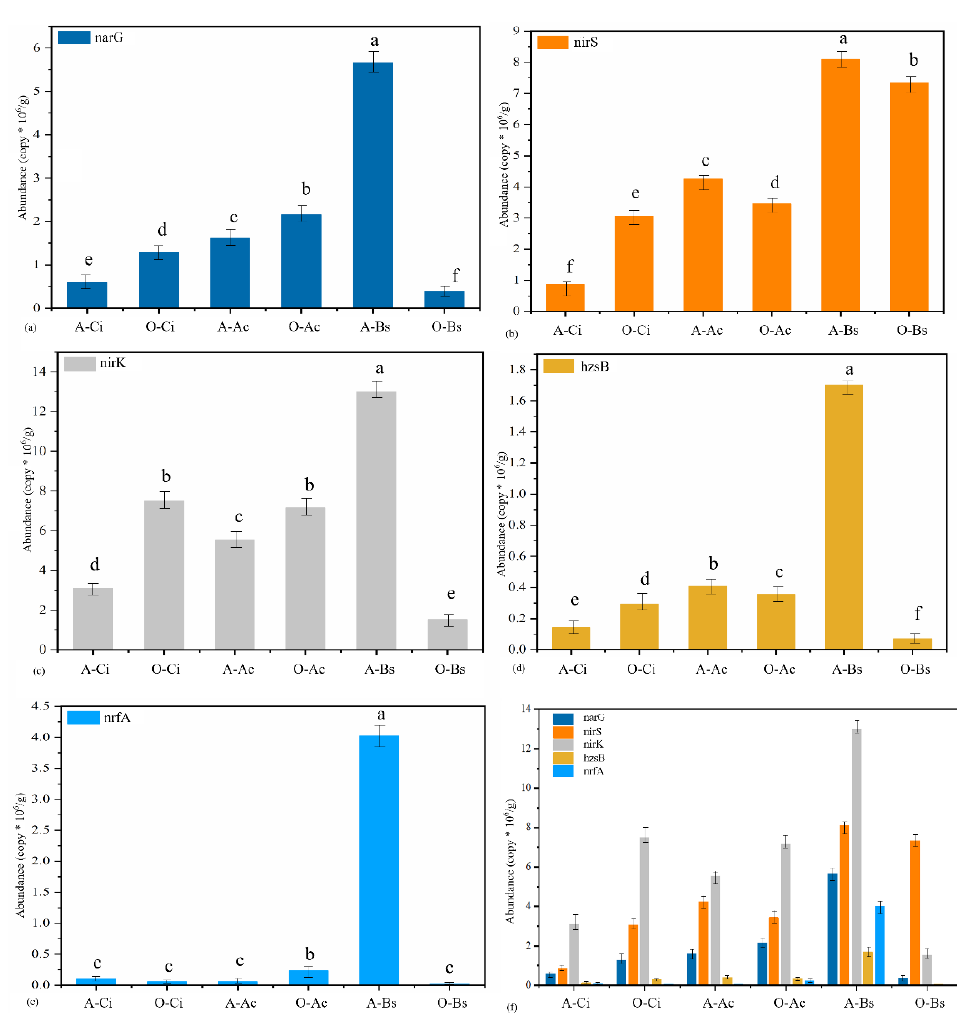
Figure 4. Five N-related relative functional genes’ abundance. ( a ) narG gene abundance among rhizosphere and bulk soils. ( b ) nirS gene abundance; ( c ) nirK gene abundance; ( d ) hzsB gene abundance; ( e ) nrfA gene abundance; ( f ) five functional genes’ abundance in total. Letters (a, b, c, d, e and f) above the bars were based on Waller-Duncan analysis at significance level of